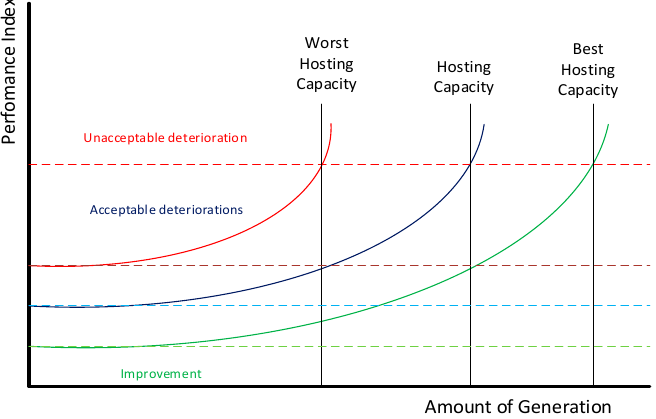
Figure 1. Hosting capacity general approach—worst, usual, and best cases.